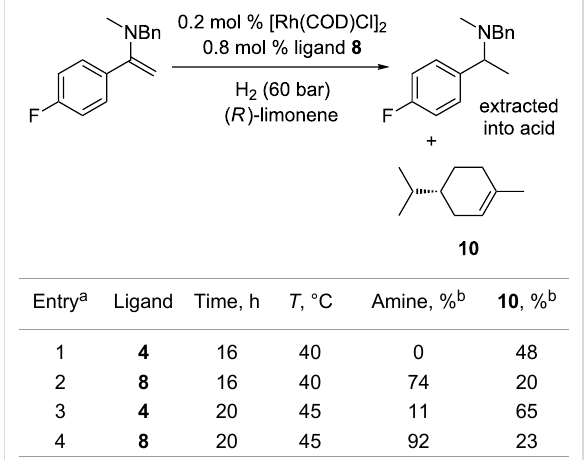
Table 3: Hydrogenation of enamine 1h in ( R )-limonene as a